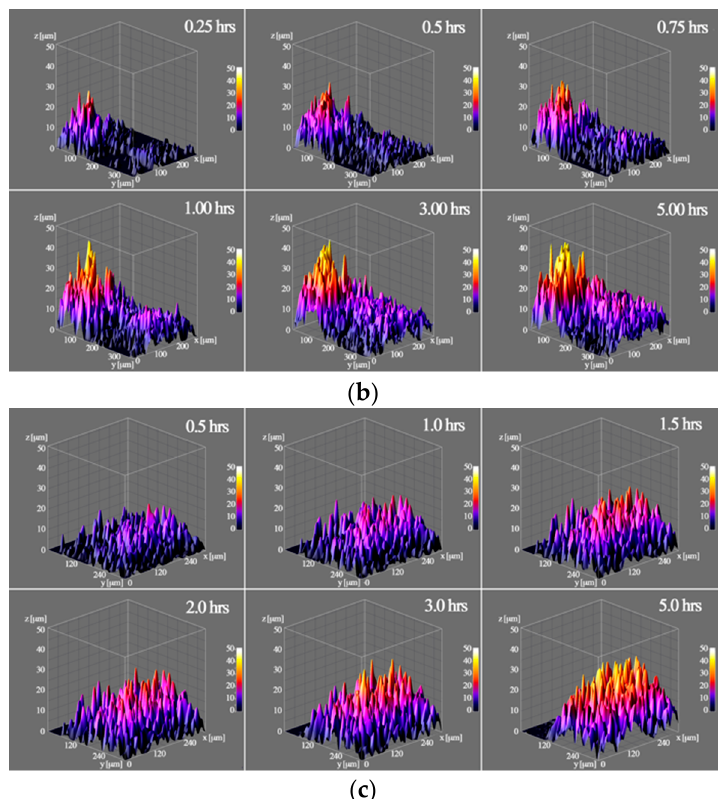
Figure 6. 3D surfaces of the thicknesses extracted from the acquired and processed data. ( a ) The 3D surface on the left is related to the thickness of the cartilage cell structure computed from the CARS signal, in the center, the 3D surface is related to thickness of the collagen and thus the ECM from the SHG signal, while on the right the 3D surface is related to the EV penetration depths in the cartilage after 5 h from the TPEF signal; ( b ) the 3D surfaces show the dynamic of the EV penetration in the cartilage during the time-lapse; in the top right corner of each image the related timeframe is depicted; ( c ) the 3D surfaces show the dynamic of the EV penetration in the chondrocytes micromass during the time-lapse, in the top right corner of each image the related timeframe is depicted.